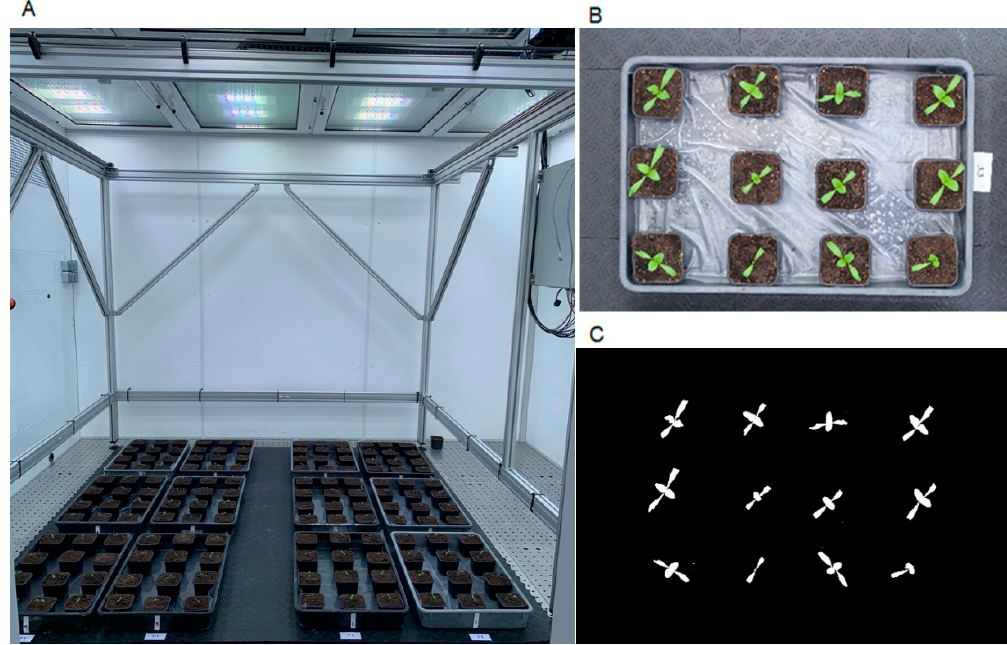
Figure 9. ( A ) Sugar beet experiment installed in Phenocave; ( B ) individual image of sugar beet plants per tray; ( C ) image after processing with the developed pipeline.